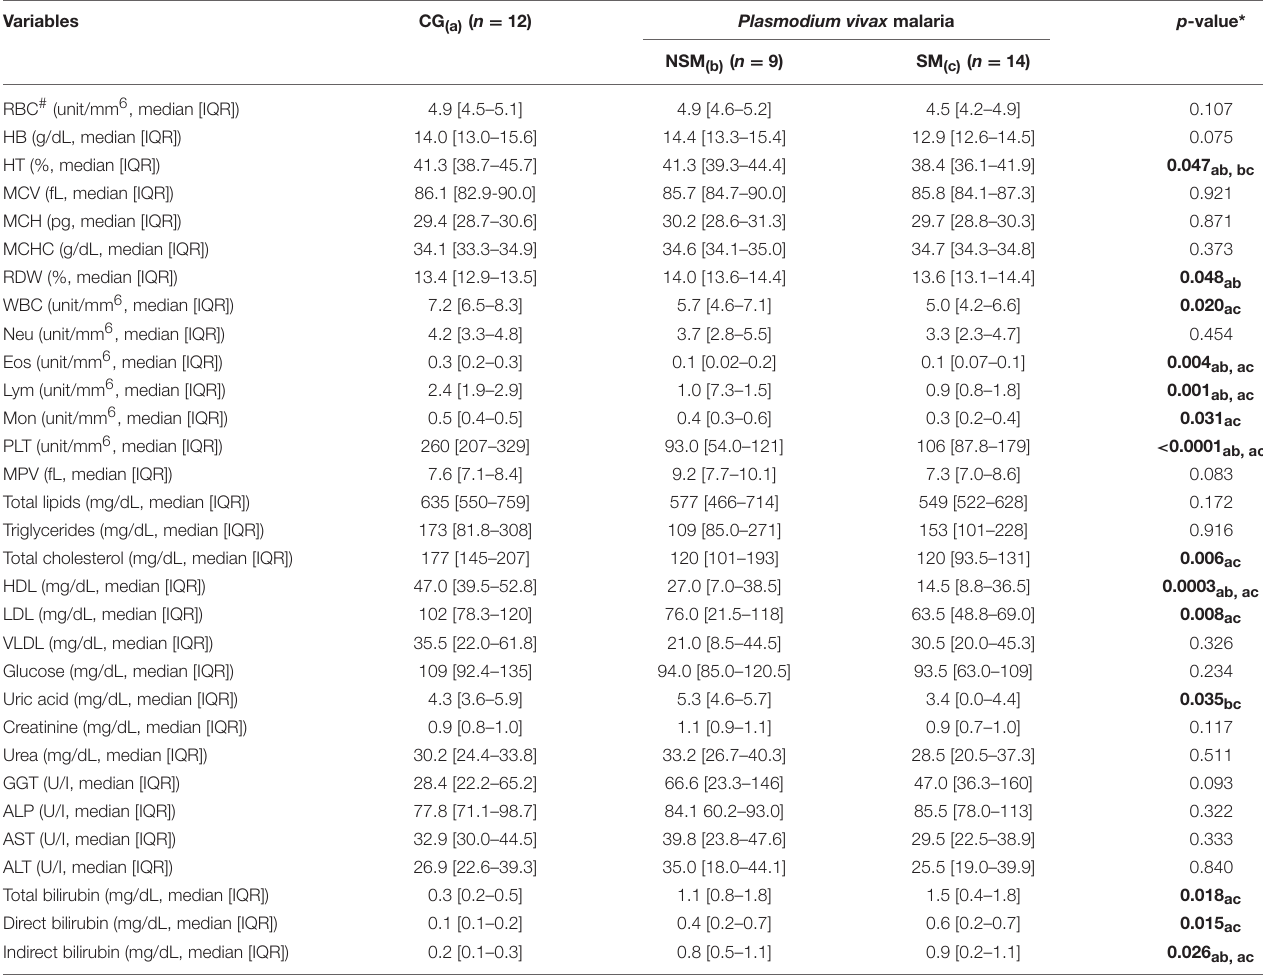
TABLE 2 | Hematological and Biochemical parameters of Control Group (CG) and Pv -malaria patients that did not Self-Medicate (NSM) and Self-Medicated (SM).